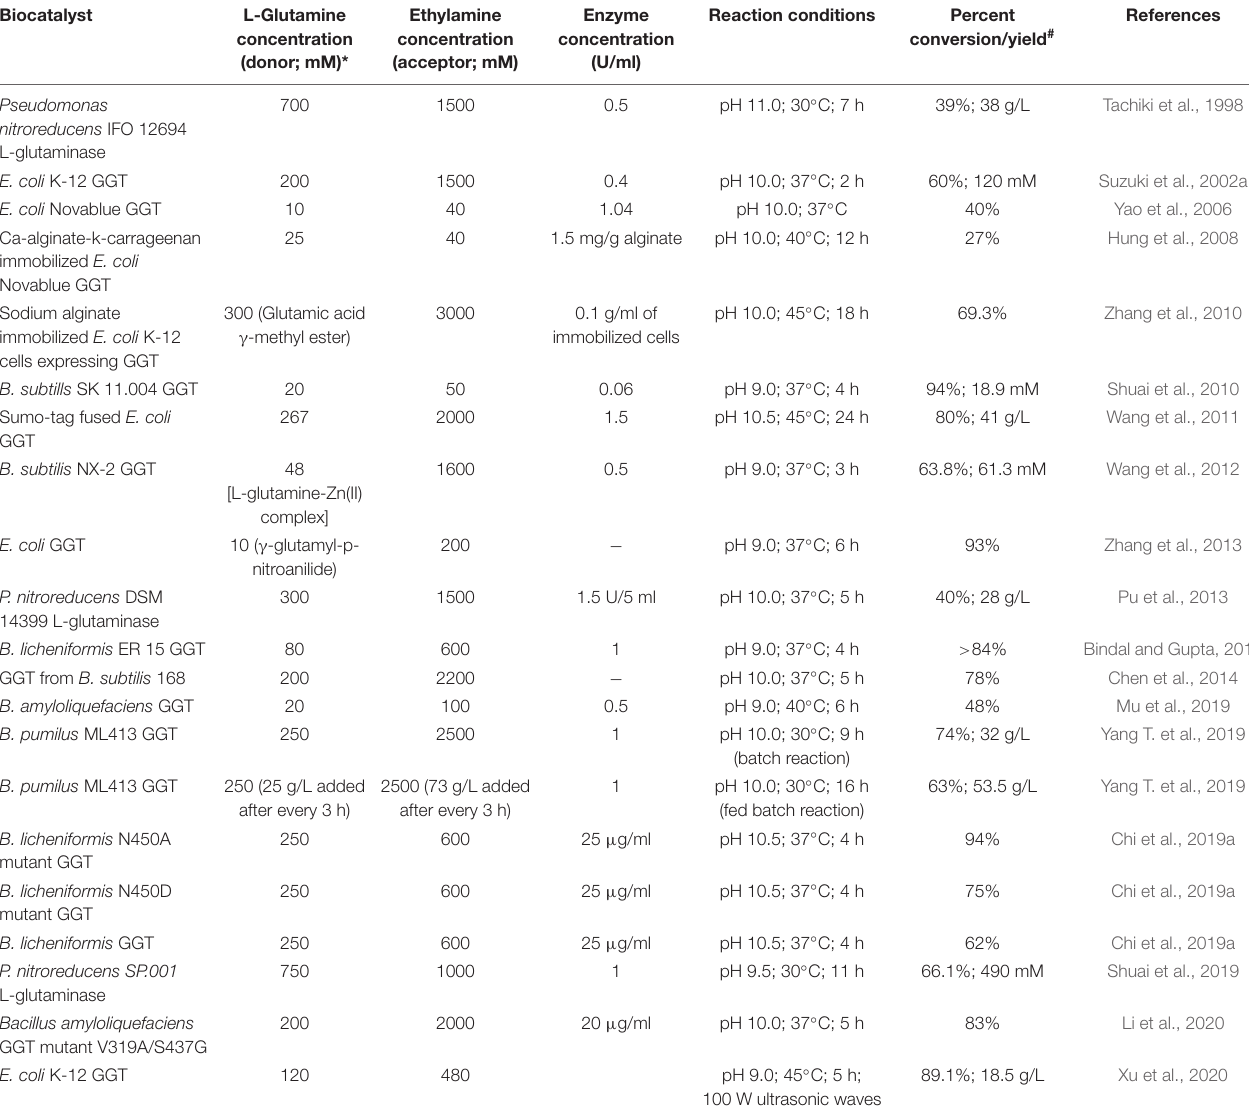
TABLE 7 | Enzymatic synthesis of L-theanine using various bacterial gamma-glutamyl transpeptidases (GGTs) as biocatalysts. Biocatalyst L-Glutamine